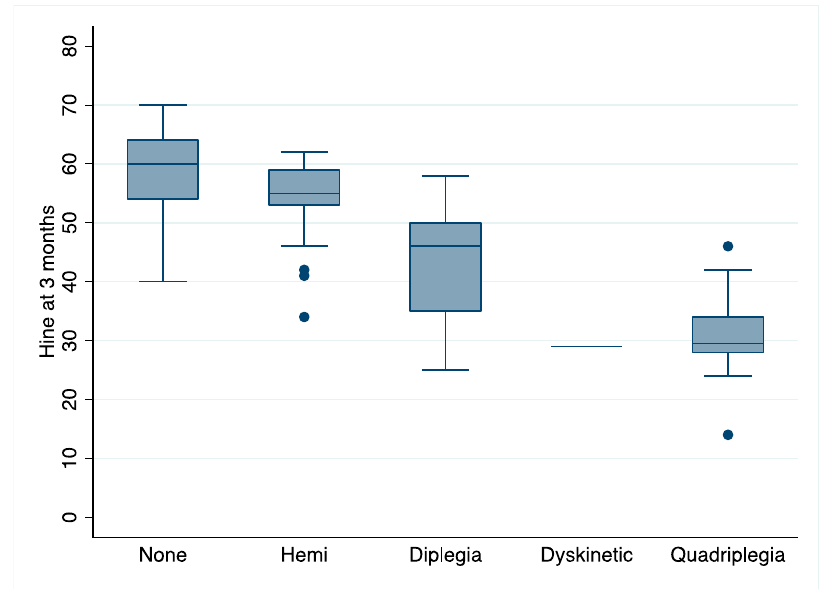
Figure 1. Hammersmith Infant Neurological Examination (HINE) scores across cerebral palsy (CP) type and topography.